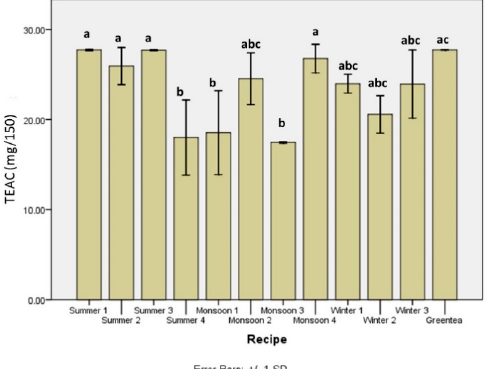
Figure 1. Antioxidative capacity of Thai identity tea recipes compared to green tea as measured by the 2,2’-azino-bis-(3-ethylbenzothiazoline)-6-sulfonic acid (ABTS) method. Letters a – c indicate a level of significance ( p < 0 . 05) .